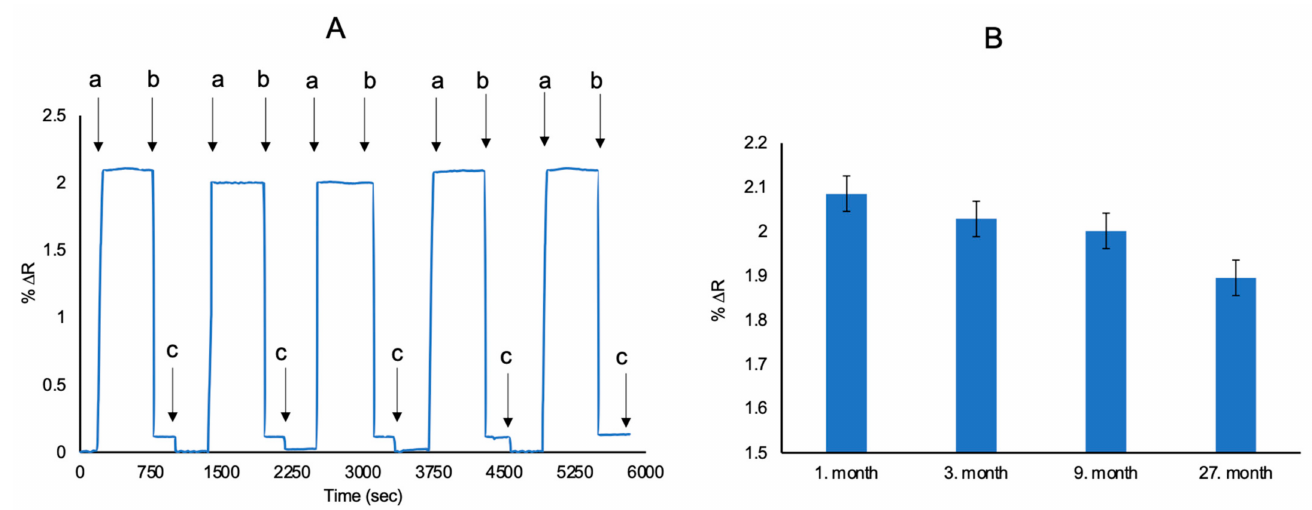
Figure 9. Reproducibility of L -Phe imprinted SPR sensors ( A ) and short-term and long-term stability of L -Phe imprinted SPR sensors ( B ) (C L-Phe : 50 µ M in all measurements) (equilibration (a), adsorption (b) and desorption